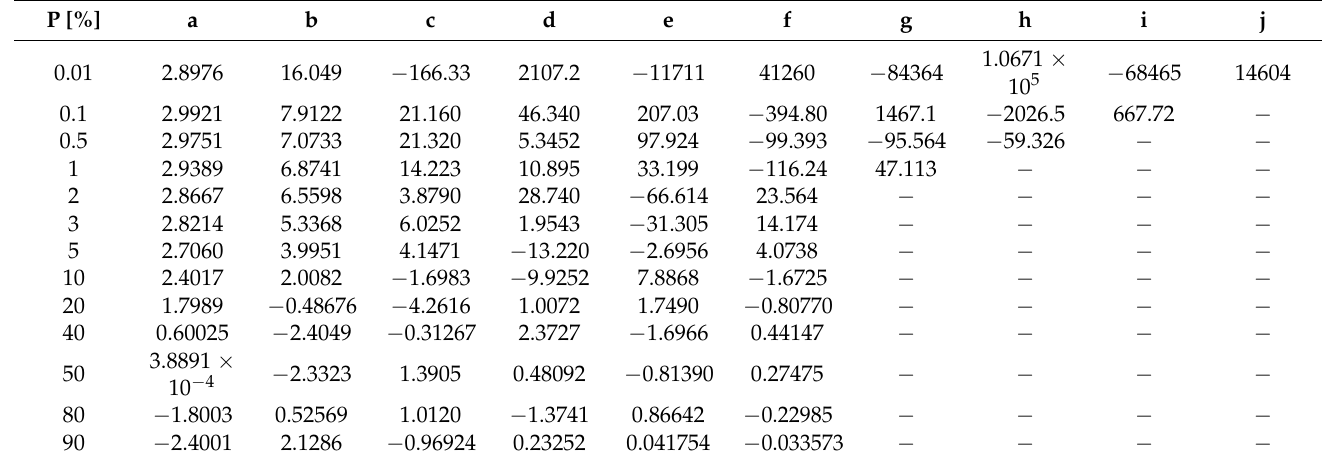
Table A5. The frequency factor for estimation with